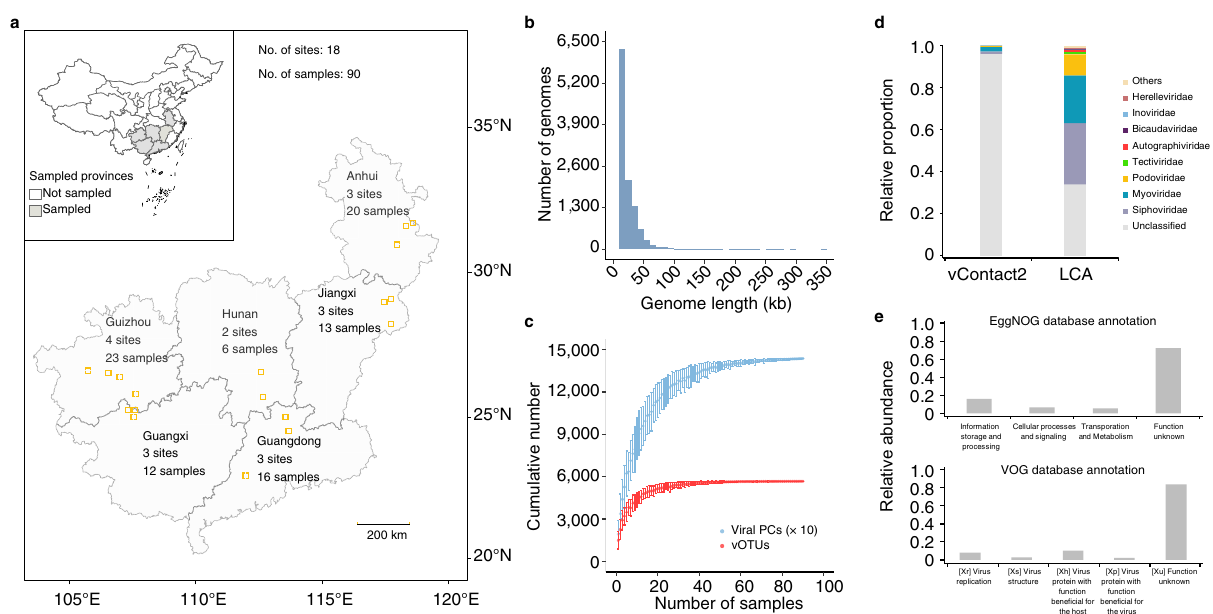
Fig. 1 Overview of acid mine drainage (AMD) sediment viruses. a Geographic distribution of collected AMD sediment samples. The provinces from which AMD sediments were sampled are presented in gray. All sampled AMD sites ( n = 18) are marked by orange squares. b Histogram showing the distribution of viral genome size. c Accumulation curve of viral operational taxonomic units (vOTUs, red) and viral protein clusters (PCs, blue) in the AMD sediment metagenomes. Dots represent the average number of vOTUs and PCs for all combinations of a given number of samples, and error bars represent the range. The numbers of viral PCs were divided by ten for better visualization. d Bar graphs showing the relative proportion and taxonomy of vOTUs based on reticulate classi fi cation method (vContact2) and Lowest Common Ancestor (LCA) algorithm. e Relative abundances of viral functions in the AMD sediments as annotated by eggNOG v5.0.0 database and VOG database. All COG categories are grouped into four types, including information storage and processing (COG categories A, RNA processing and modi fi cation; B, chromatin structure and dynamics; J, translation, ribosomal structure and biogenesis; K, transcription; L, replication, recombination and repair), cellular processes and signaling (D, cell cycle control, cell division, chromosome partitioning; M, cell wall/membrane/envelope biogenesis; N, cell motility; O, posttranslational modi fi cation, protein turnover, chaperones; T, signal transduction mechanisms; U, intracellular traf fi cking, secretion and vesicular transport, V, defence mechanisms; W, extracellular structures; Y, nuclear structure; Z, cytoskeleton), metabolism and transportation (C, energy production and conversion; E, amino-acid transport and metabolism; F, nucleotide transport and metabolism; G, carbohydrate transport and metabolism; H, coenzyme transport and metabolism; I, lipid transport and metabolism; P, inorganic ion transport and metabolism; Q, secondary metabolites biosynthesis, transport and catabolism), and unknown functions (S, unknown; Unannotated proteins). Source data are provided in the Source Data fi